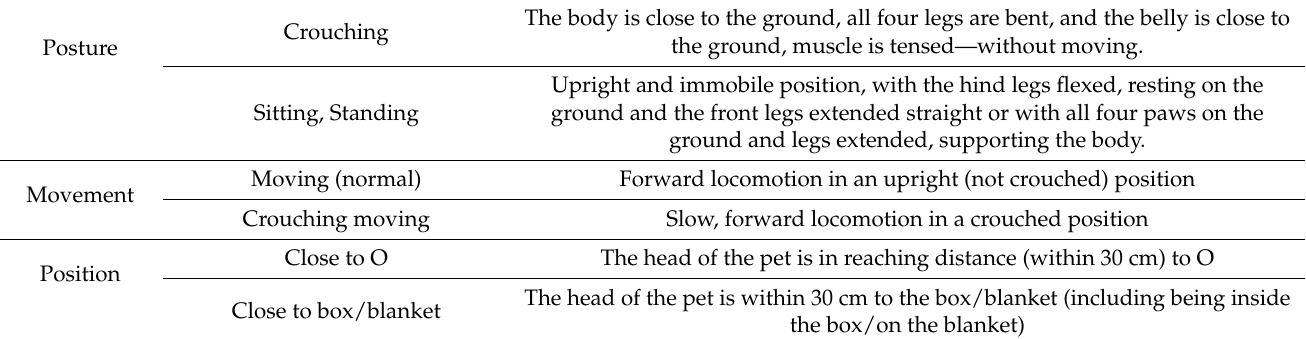
Table 1. Description of the behaviours observed in both cats and